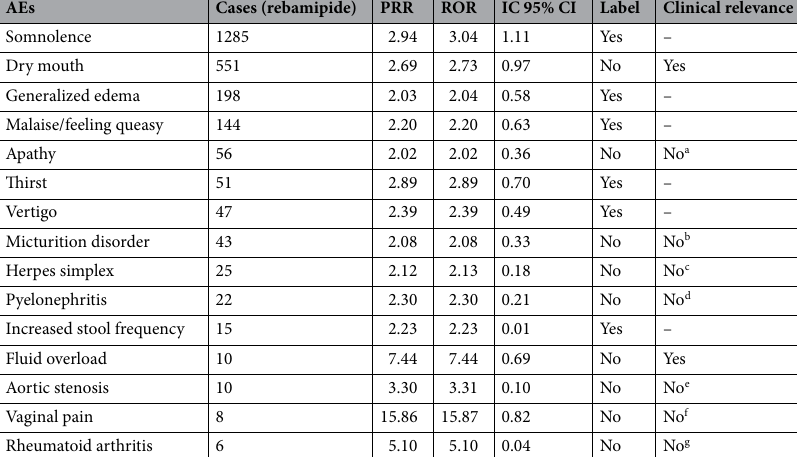
Table 2. The AE signals of rebamipide (analysis of drug–AE pairs regardless of causality). AE adverse event, CI confidence interval, PRR proportional reporting ratio, ROR reporting odds ratio. a 43 out of 56 (76.8%) used drugs that act on the central nervous system. b 35 out of 43 (81.4%) used anticholinergic agents. c 14 out of 25 (56.0%) used anticancer agents, and 6 out of 25 (24.0%) used immunosuppressive agents. d 4 out of 22 (18.2%) used antibiotics, 6 out of 22 (27.3%) used non-steroidal anti-inflammatory drugs (NSAIDs), 4 out of 22 (18.2%) used both antibiotics and NSAIDs, and 3 out of 22 (13.6%) used diuretics. e All had more than two risk factors for aortic stenosis (diabetes, dyslipidemia, and hypertension). f 5 out of 8 (62.5%) used topical povidone-iodine, 1 out of 8 (12.5%) used estriol, and 1 out of 8 (12.5%) used a topical antifungal agent. g 4 out of 6 (66.7%) had a history of rheumatoid